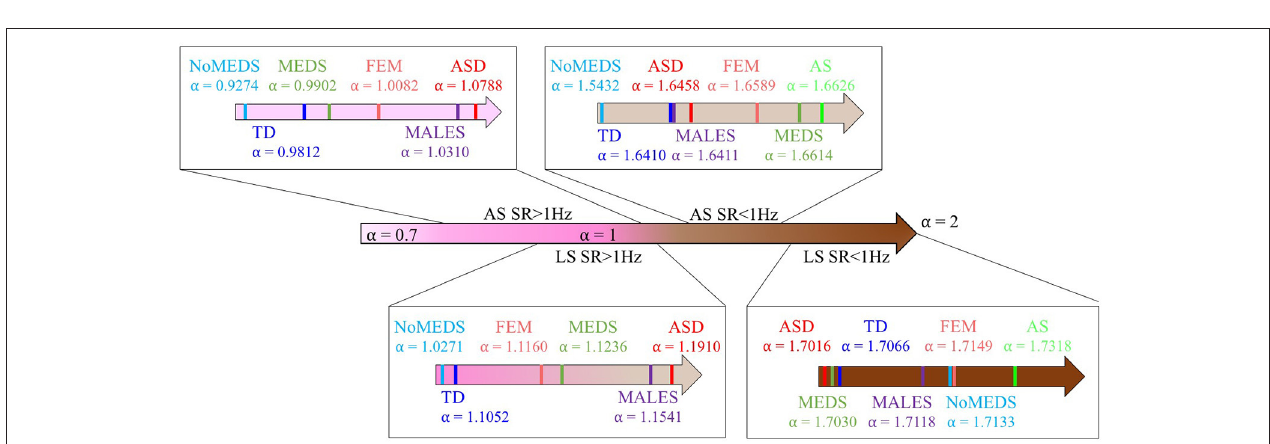
FIGURE 9 | Summary of the mean of alpha values from each group from all sites from ABIDE I and ABIDE II and their relationship with the different types of noise in Appendix Figure A2.